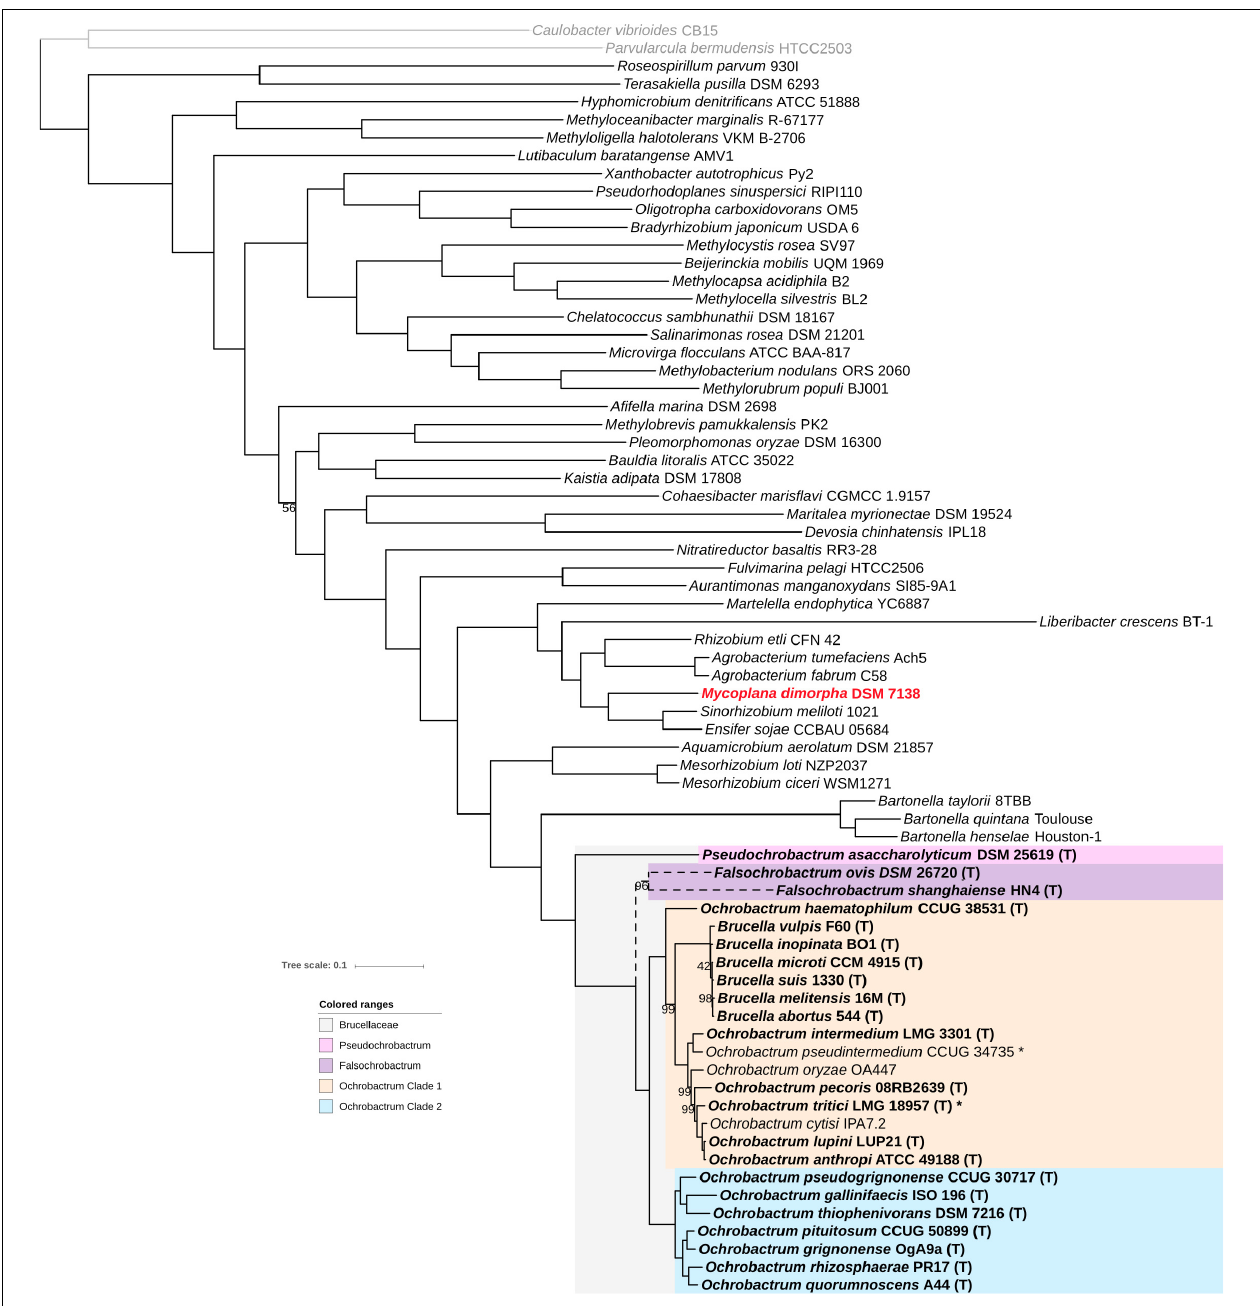
FIGURE 1 | Position of the Brucellaceae genomes in the Rhizobiales phylogeny. The ML phylogenetic tree was computed using RaxML from an alignment of 145 core proteins, and rooted using two Caulobacteriales genomes (depicted in gray). Branching support was estimated using 100 bootstrap replicates, with only values lower than 100% displayed. The Brucellaceae clade is indicated with gray background. Brucellaceae type strains are highlighted with bold labeling. A star indicates a genome sequenced in the current study. Pseudochrobactrum , Falsochrobactrum , and Ochrobactrum clade 1 and clade 2 are indicated with pink, purple, orange, and blue backgrounds, respectively. The misclassified Mycoplana dimorpha genome is labeled in red. Branching of Falsochrobactrum spp. is depicted in dashed lines to reflect conflicting topology with the phylogeny displayed in Figure 2 .